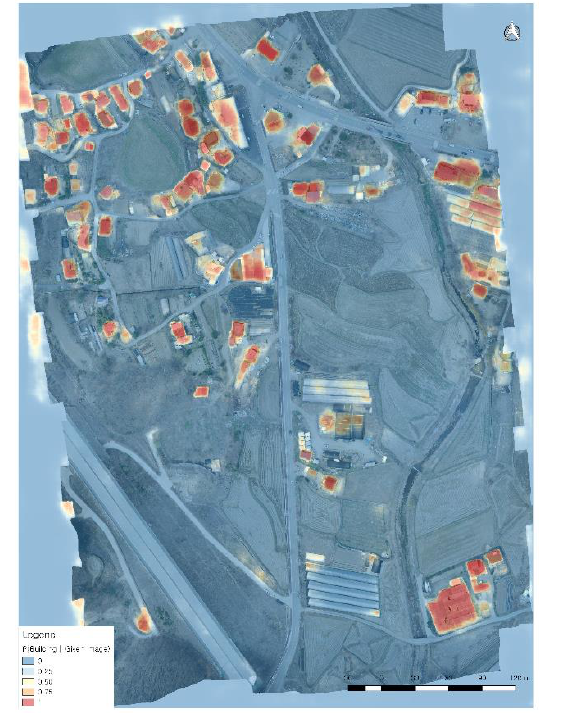
Figure 13.Building probability